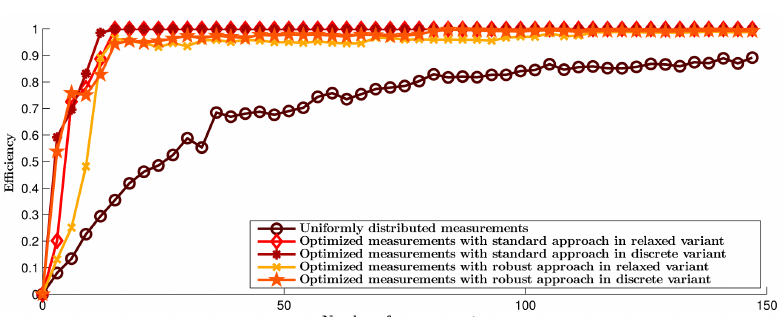
Figure 5. Averaged frequency of measurements from 10 optimization runs with the C 2 -model and three measurement per iteration with standard deviation 10 − 2 of the measurement error.